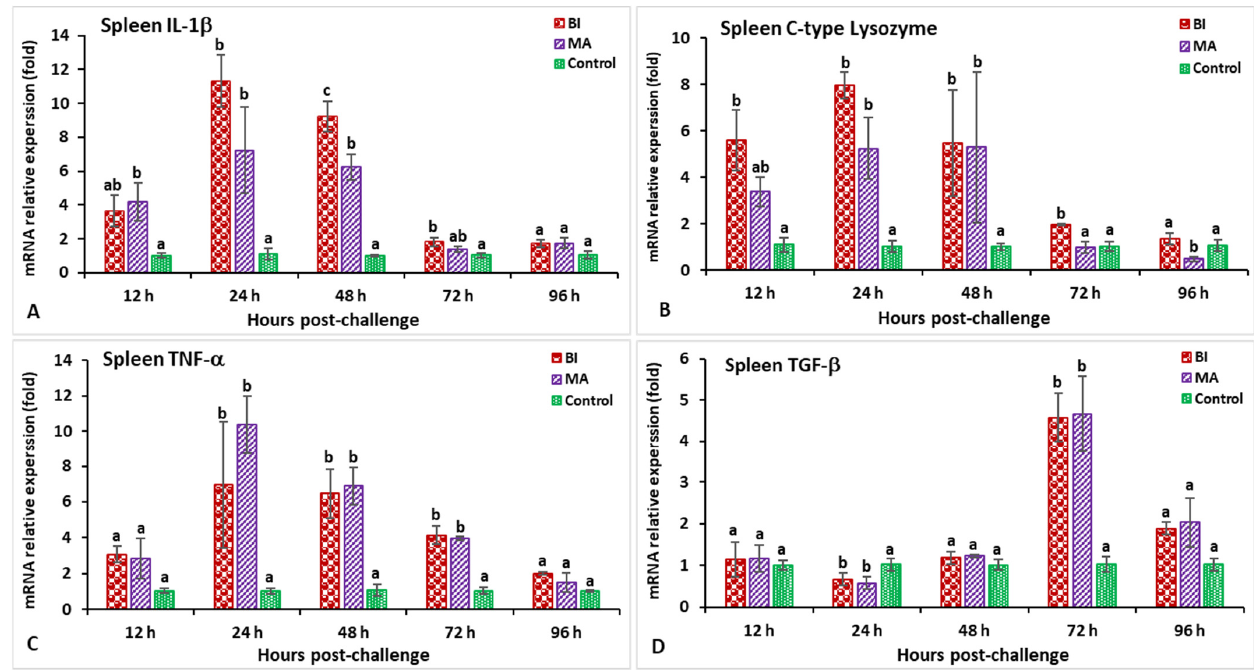
Figure 9. The gene expression of IL-1 β ( A ), C-type lysozyme ( B ), TNF- α ( C ), and TGF- β ( D ) in the spleens of orally vaccinated fish after being challenged by Aeromonas hydrophila (mean ± SE, n = 3). Dissimilar letters denote significant differences ( p < 0.05).